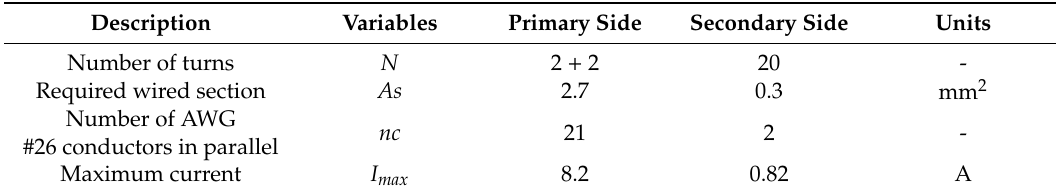
Table 6. Characteristics of the high-frequency transformer